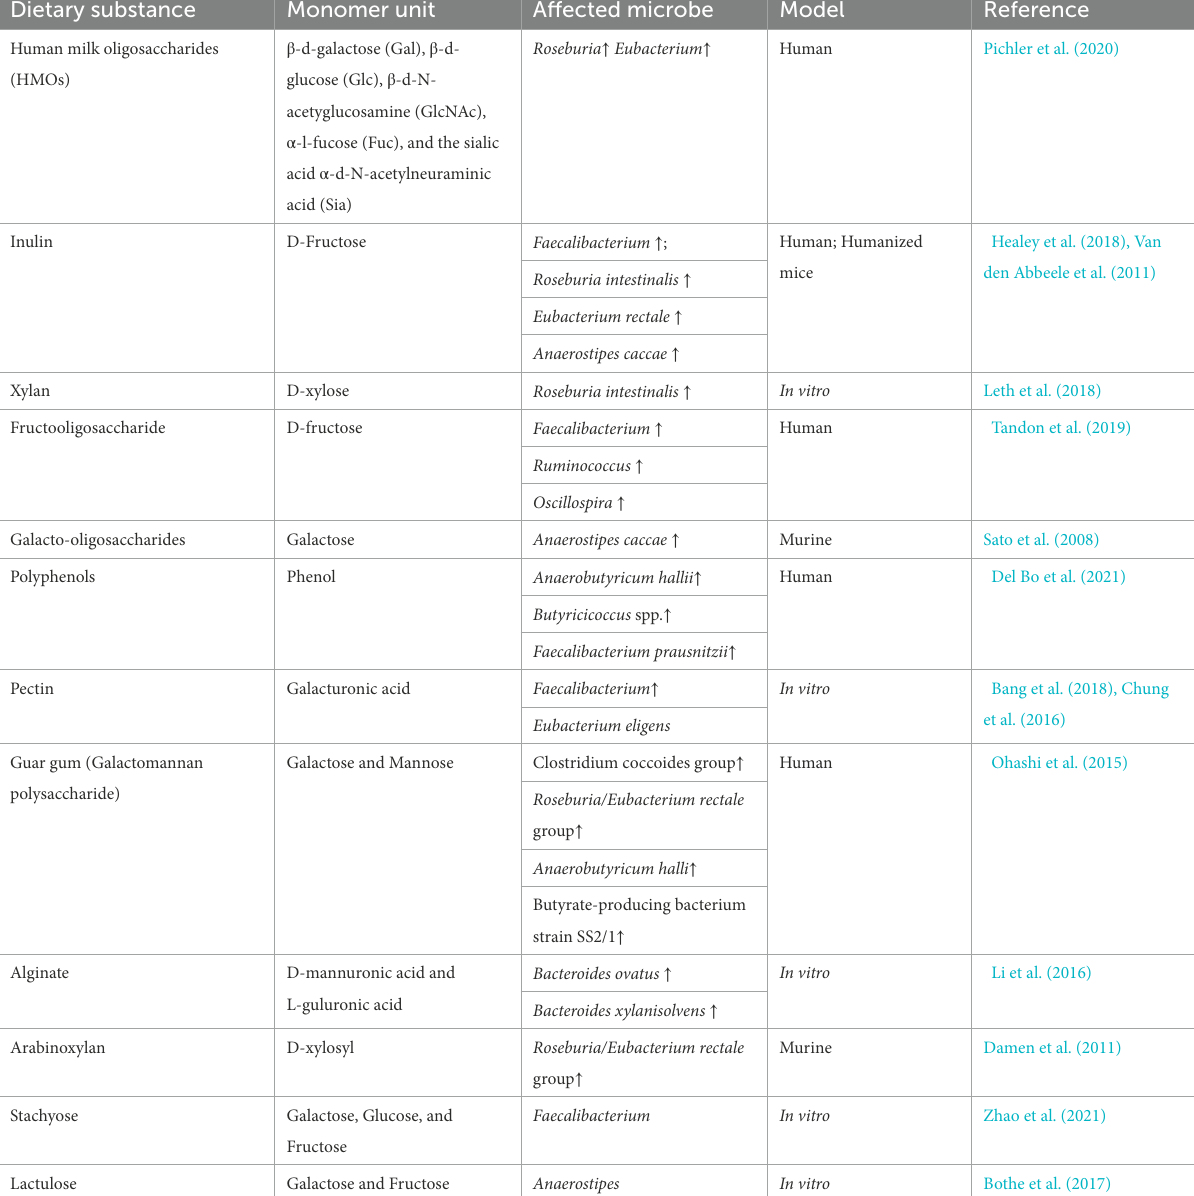
TABLE 2 Impact of different fiber and bioactive metabolites on various gut butyrate producers. Dietary